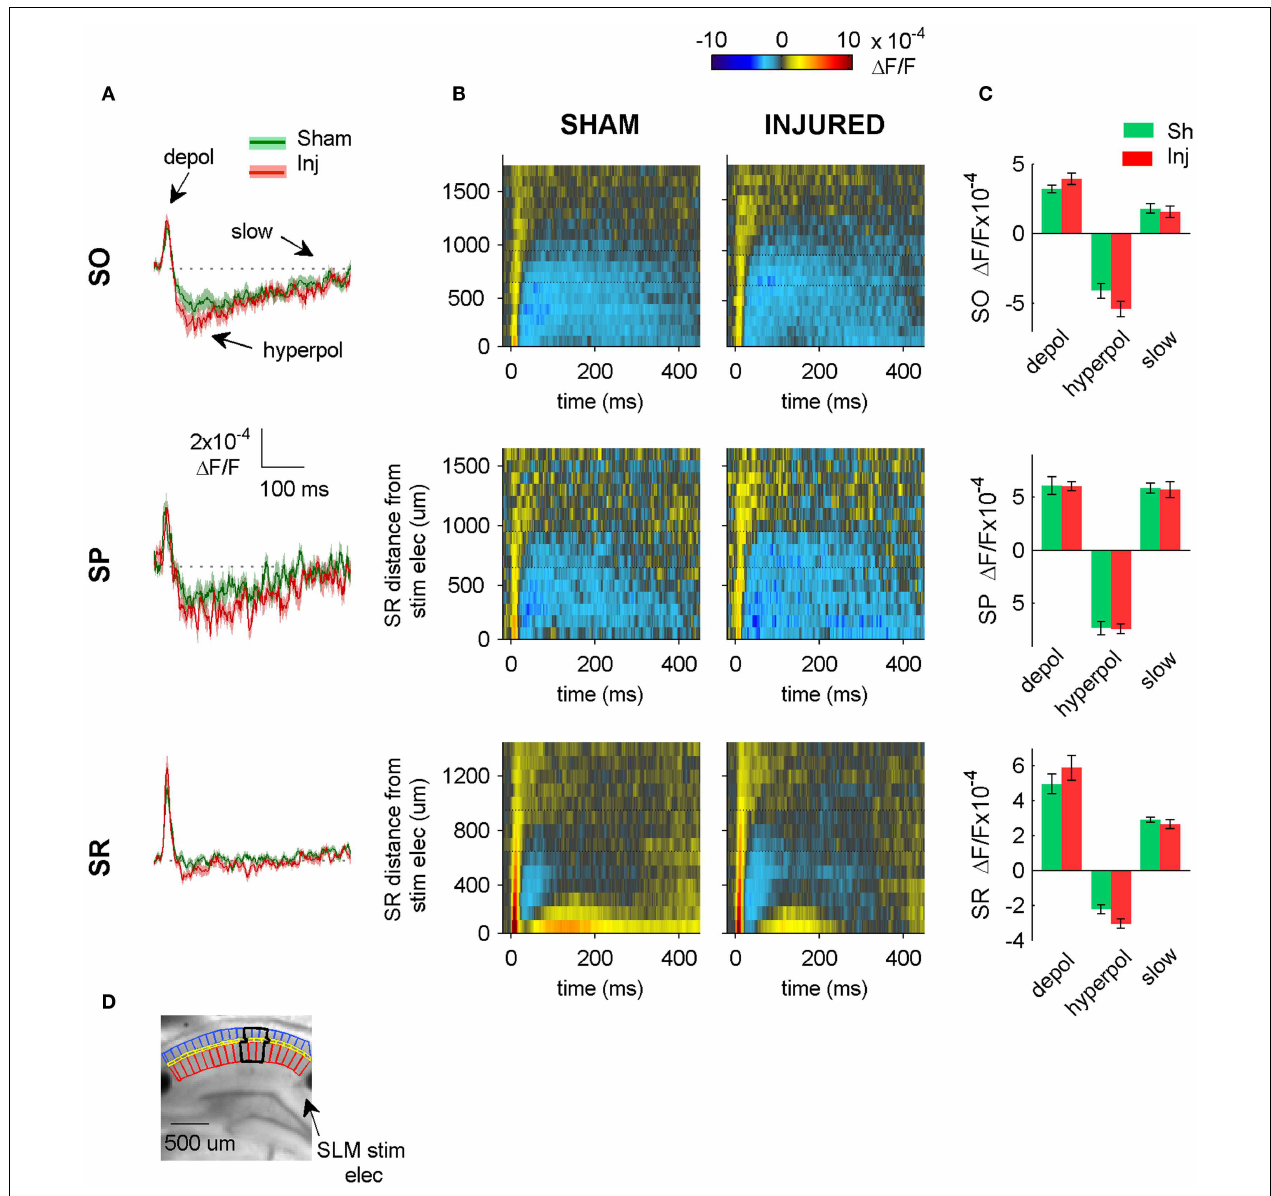
SP or SO hyperpolarization. Horizontal dotted lines on rasters indicate analysis region. (C) Group data shows no significant differences in the SO responses to SLM stimulation, although there was a moderate increase in SR hyperpolarization. (D) Photograph of representative slice depicting analysis region (black outline) and location of SLM stimulating electrode. Stimulus: 300 µ A. Sham n = 13, injured n = 11. SO, stratum oriens; SR, stratum radiatum; SLM, stratum lacunosum-moleculare; depol, depolarization; hyperpol, hyperpolarization; stim elec, stimulating